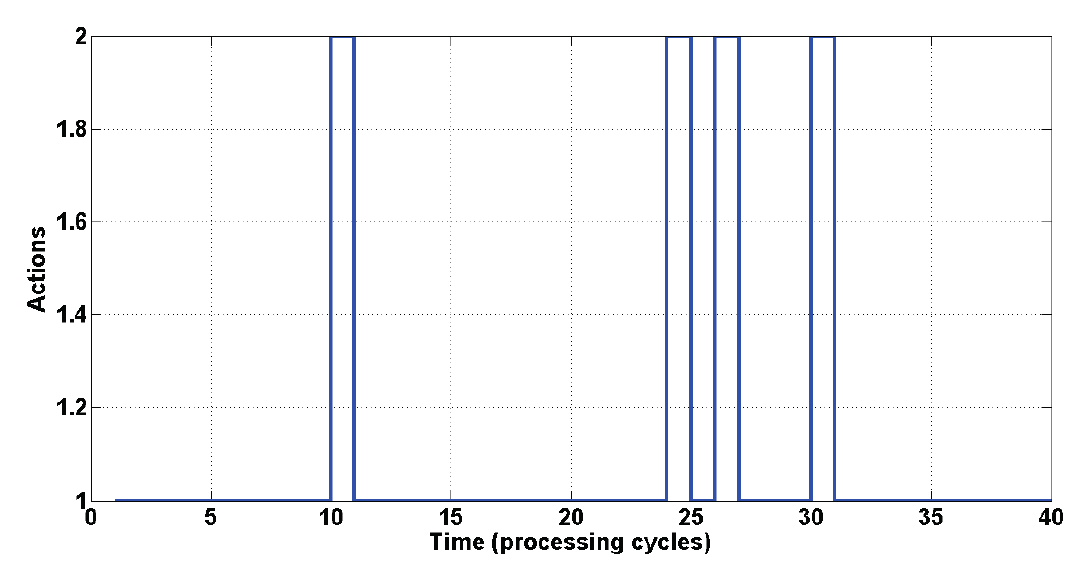
Figure 6. The switching sequence among the two